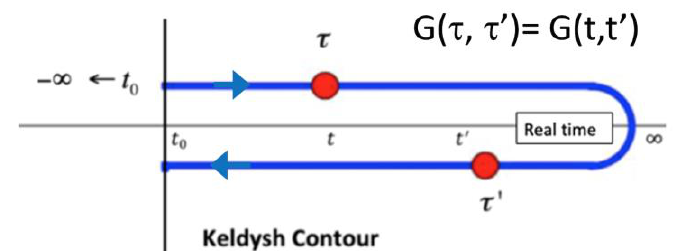
and then back from t to −∞ (C